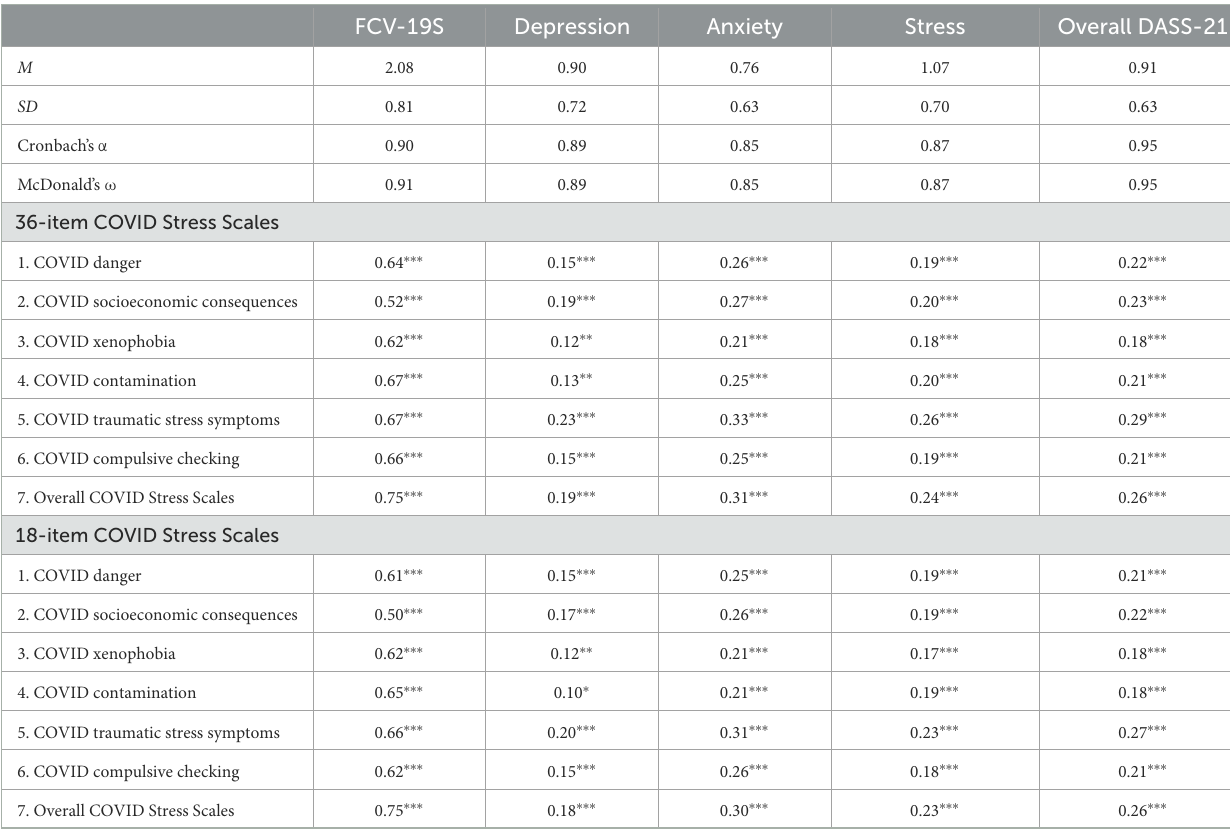
TABLE 5 Correlations of COVID Stress Scales with fear of COVID-19 and negative emotional